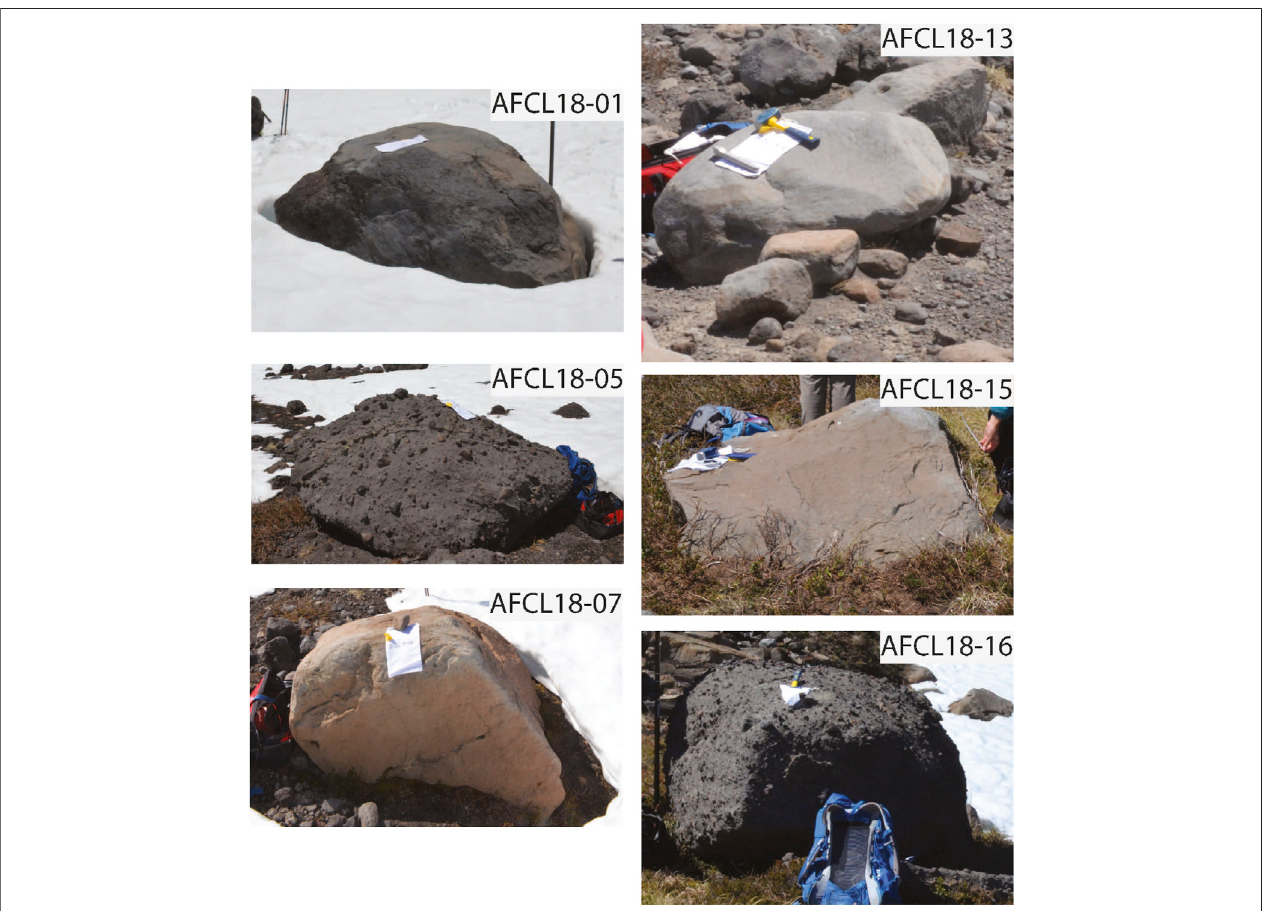
FIGURE 5 | Representative basaltic boulders (conglomerates and fi ne-grained crystalline) sampled for 36 Cl surface exposure dating.